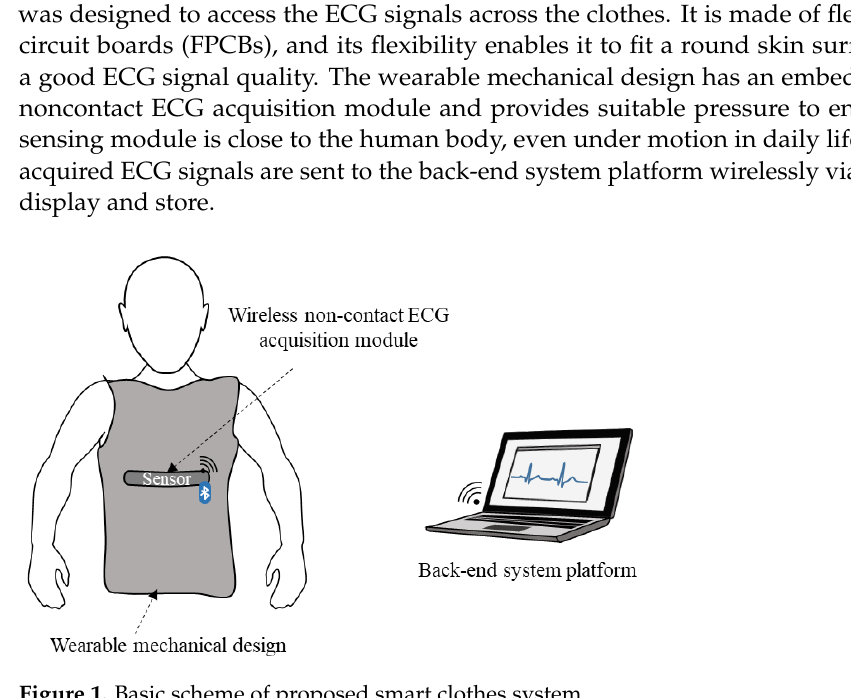
Figure 1. Basic scheme of proposed smart clothes system.